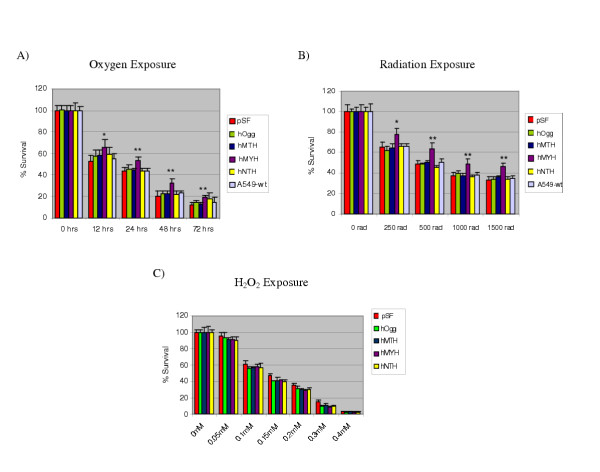
Cell survival analysis following O2, IR, and H2O2 treatments. A549 cells over-expressing hOgg1, hMYH, hMTH and hNTH following (A) O2, (B) IR, and (C) H2O2. Brackets indicate statistical significance at * p < 0.05 and ** p < 0.001 compared to pSF91.1 at each individual dose for 1 representative experiment.